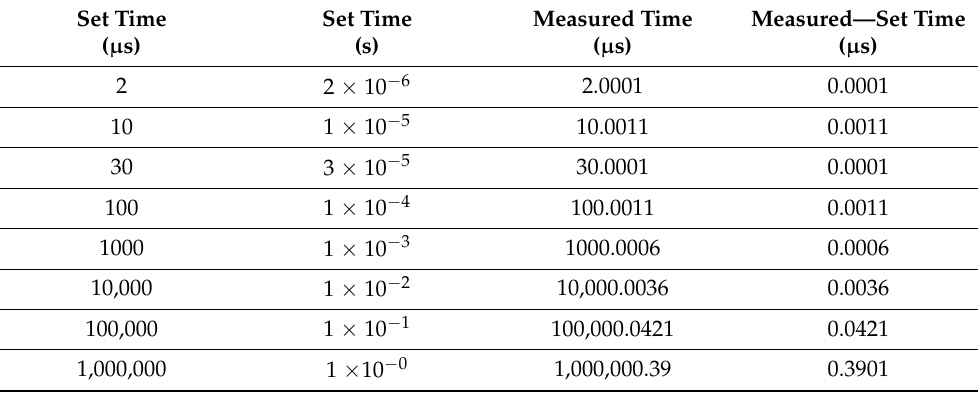
Table 6. Measurement results with OCXO